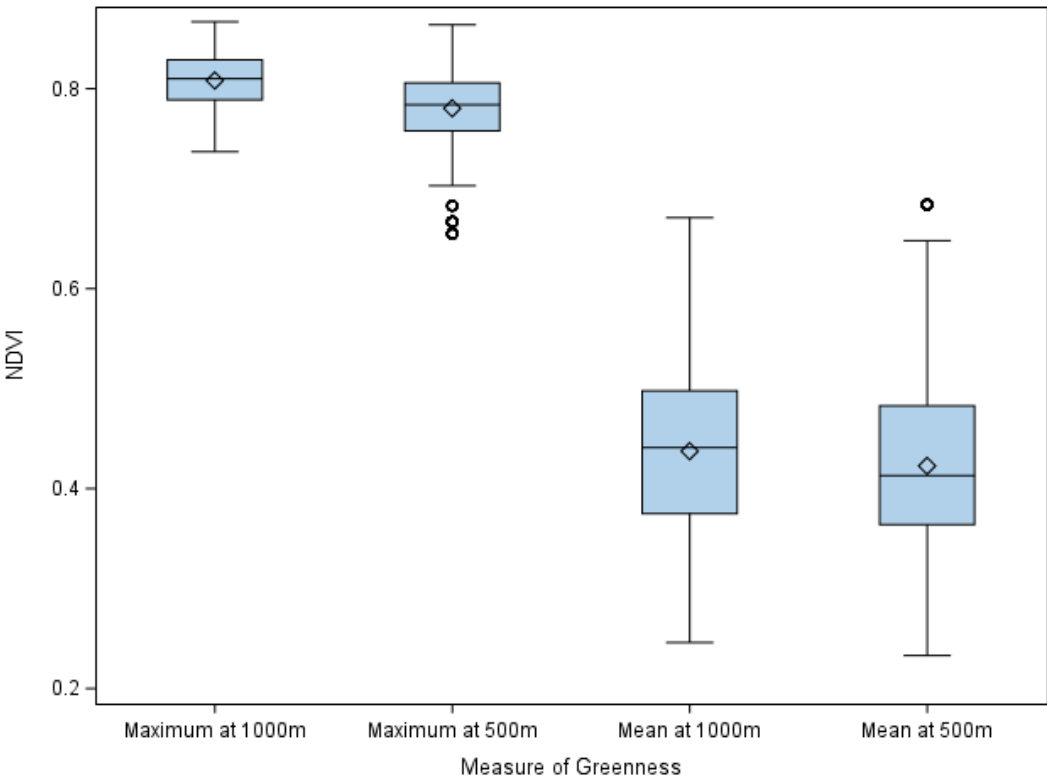
Figure 1. Distributions of school-based greenness by measure. Median (interquartile range) for maximum NDVI at 1000 m and 500 m and mean NDVI at 1000 m and 500 m are: 0.81 (0.04), 0.78 (0.05), 0.44 (0.12), and 0.41 (0.12), respectively. Abbreviations: NDVI, Normalized Difference Vegetation Index.